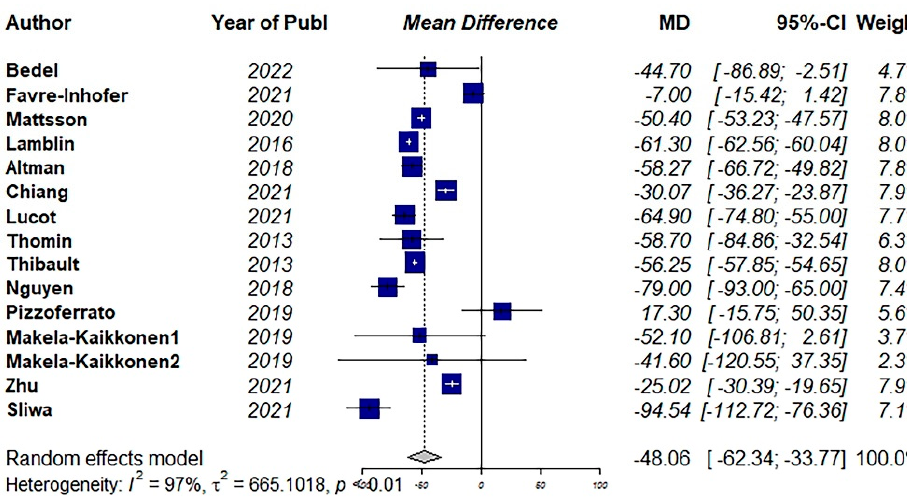
Figure 3. Pooled mean difference of the effect of surgical intervention (vaginal and abdominal surgery) on total quality of life score using the Pelvic Floor Distress Inventory Questionnaire (PFDI)